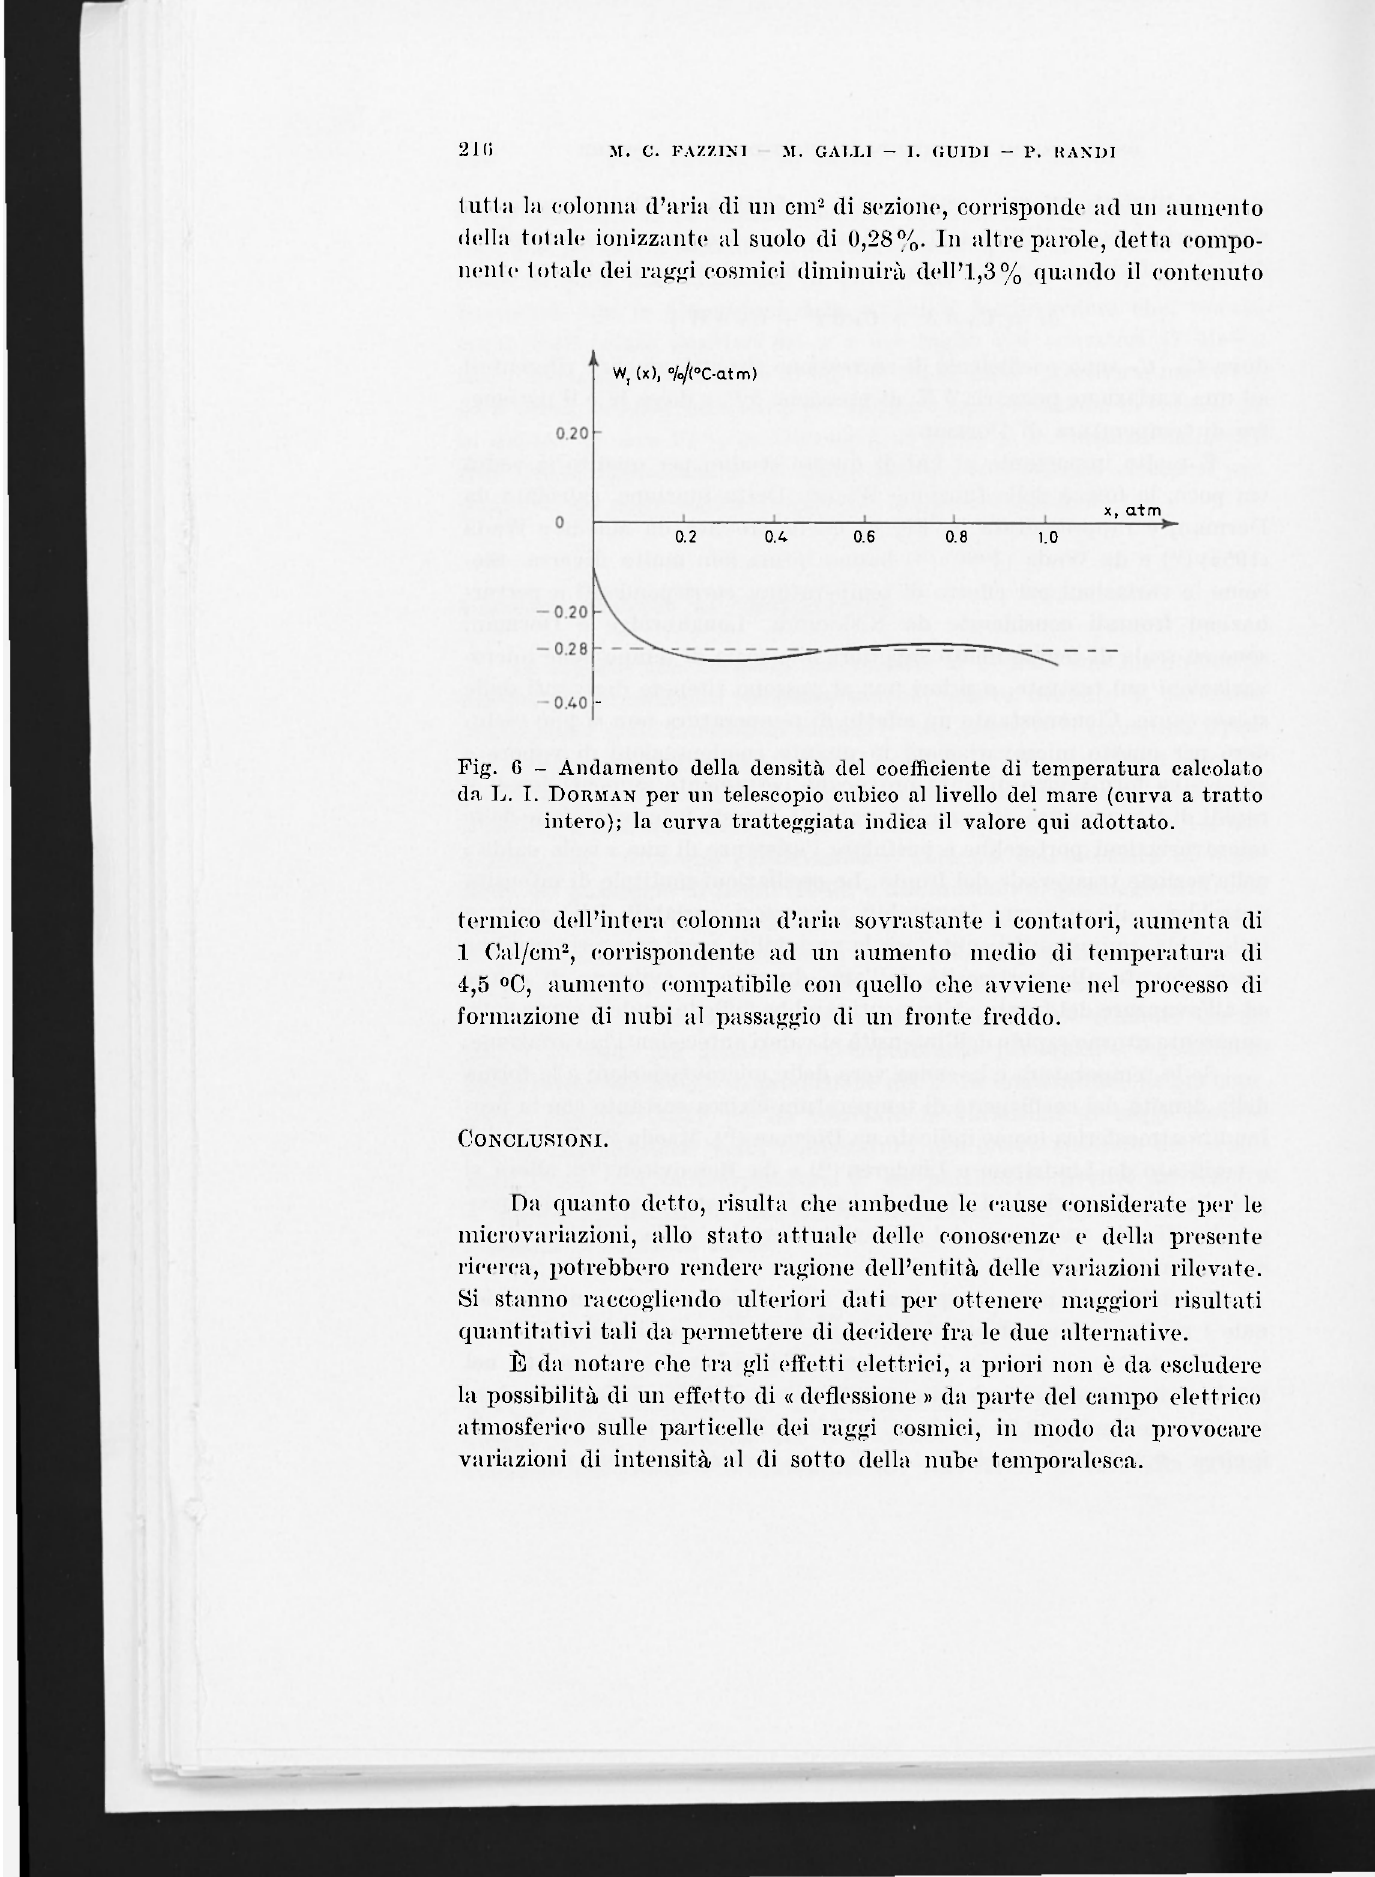
Fig. C - Andamento della densità del coefficiente di temperatura calcolato da L. I. DORMAN per un telescopio cubico al livello del mare (curva a tratto intero); la curva tratteggiata indica il valore qui adottato.